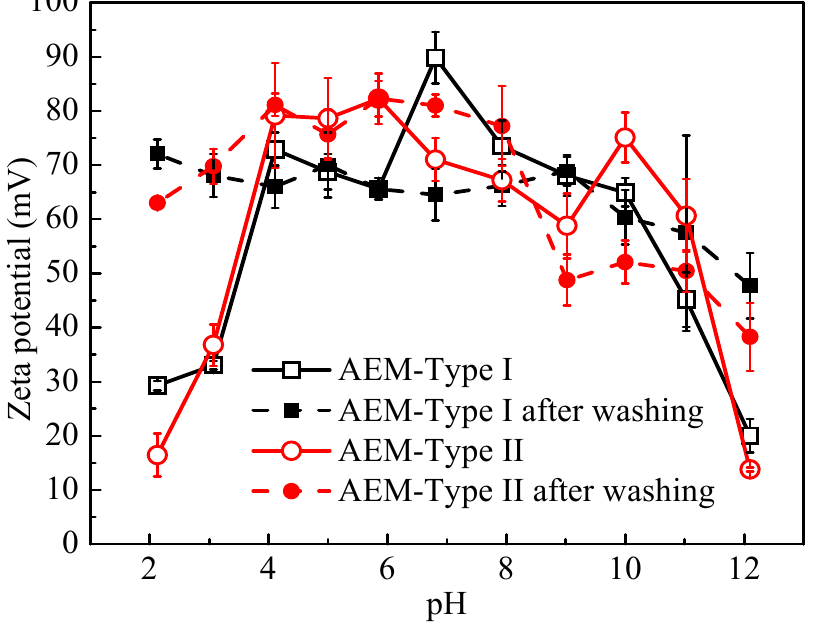
Figure 7. Zeta potential in membrane surface of AEM-Type I and AEM-Type II as a function of pH value in 0.5 M NaCl solution.